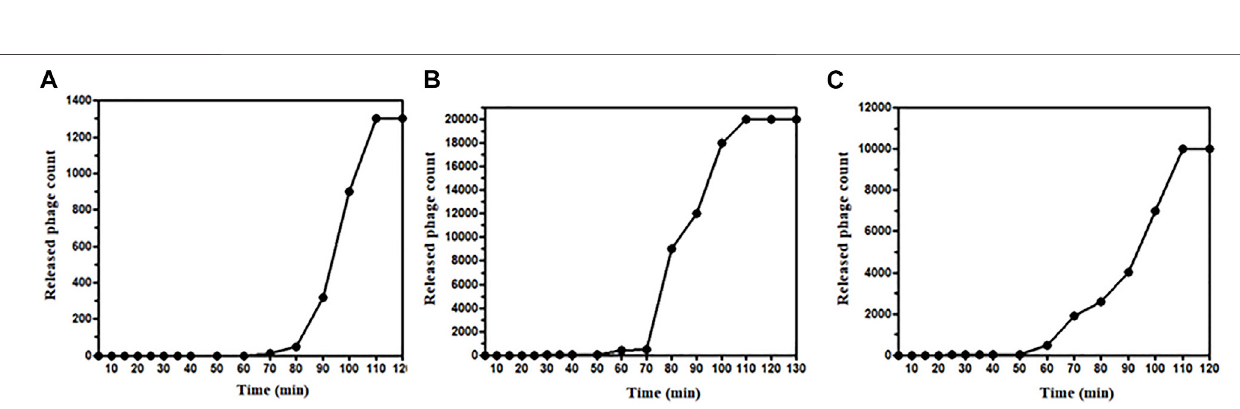
Frontiers in Pharmacology |